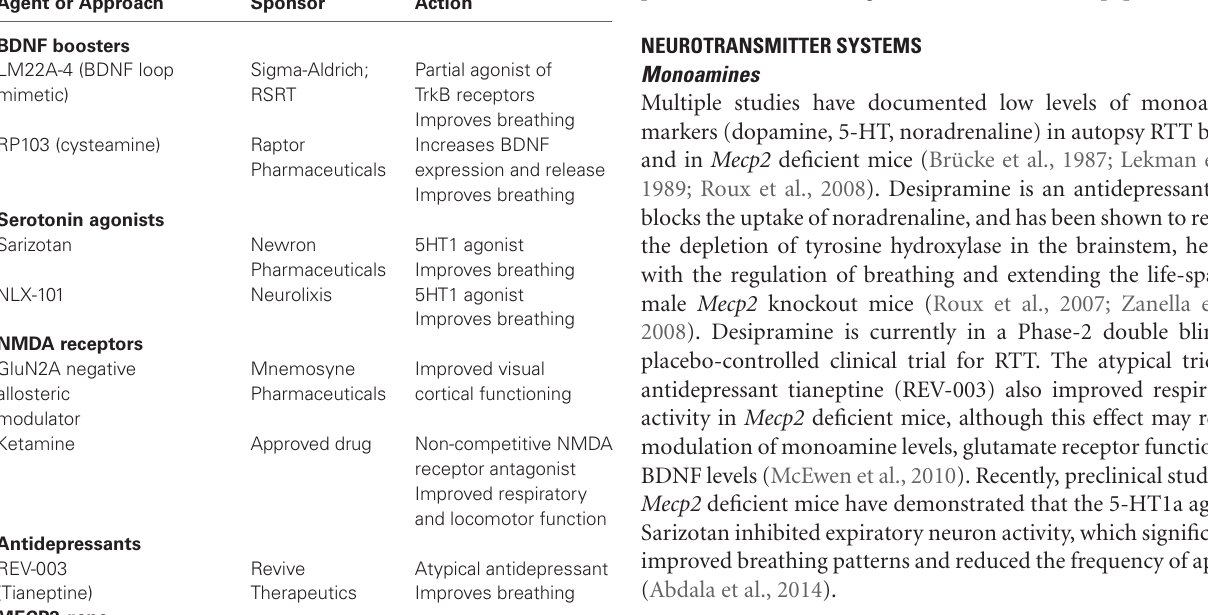
Table 3 | Current preclinical trials in Mecp2 deficient mice . Agent or